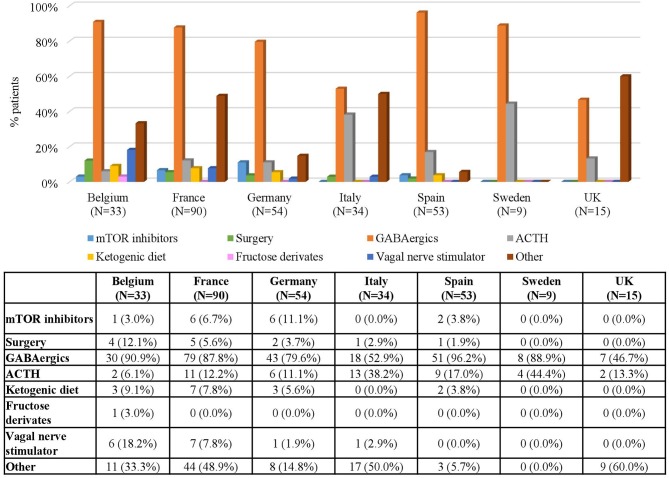
Treatments for Infantile Spasms by Country. Patients may receive more than one treatment.